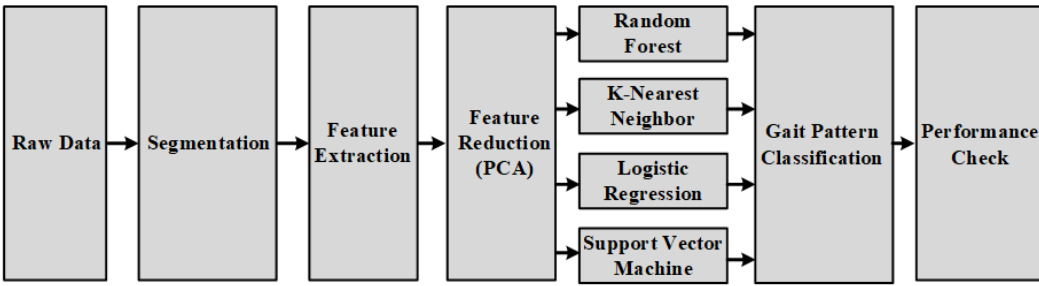
Figure 1. Block diagram for the identification of the gait patterns using pressure, three-axis accelerometer and three-axis gyroscope sensors. Four machine learning algorithms were applied—random forest, k-nearest neighbor, logistic regression and support vector machine—to classify five gait types.